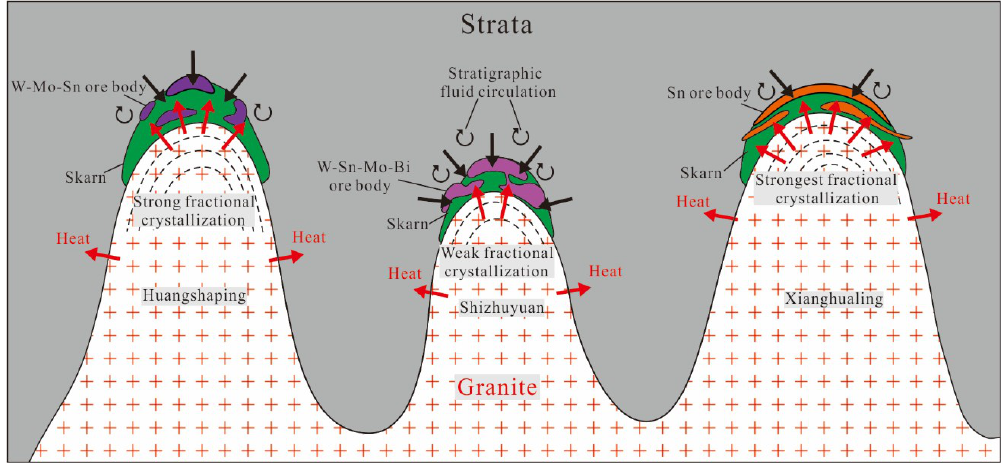
Figure 11. A genetic model for W–Sn polymetallic skarn deposits in the Nanling Range, South China, showing relative material contributions from granite and strata, respectively.